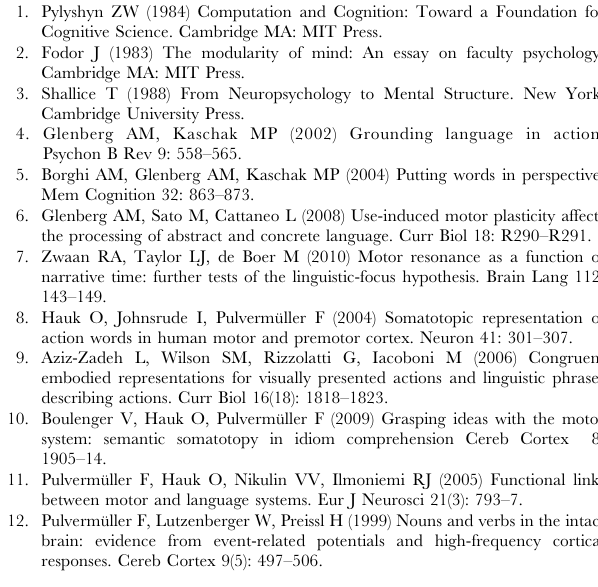
Table S1 List of all experimental sentences. Each sentence is reported with its associated value of: V F = Verb Frequency; O C F = Object Complement Frequency; V No S = Verb Number of Syllables; S No S = Sentence Number of Syllables; IMAG = Imageability; MOT R = Motor Relatedness. In italic the English translation of each sentence. Frequencies are absolute values in the CoLFIS database (http://www.ge.ilc.cnr.it/